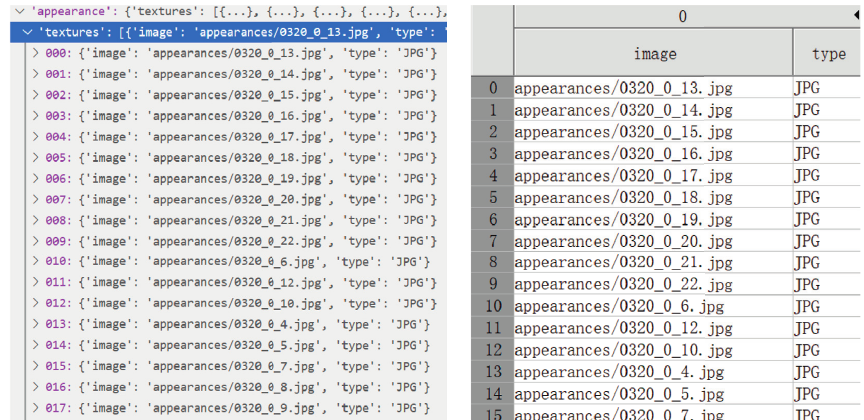
Figure 11: Original form in JSON (left) and resultant form in HDF (right), with 33.388:1 compression ratio in texture case; the source file is 3-20-DELFSHAVEN from [35].